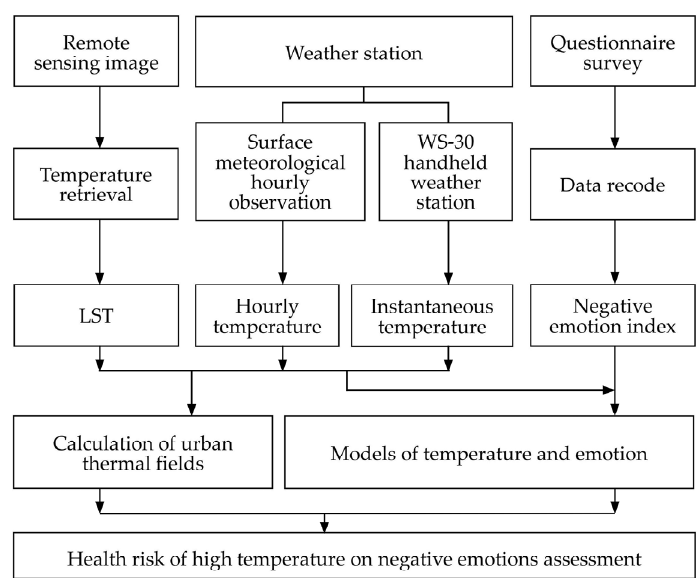
Figure 2. Research framework of this